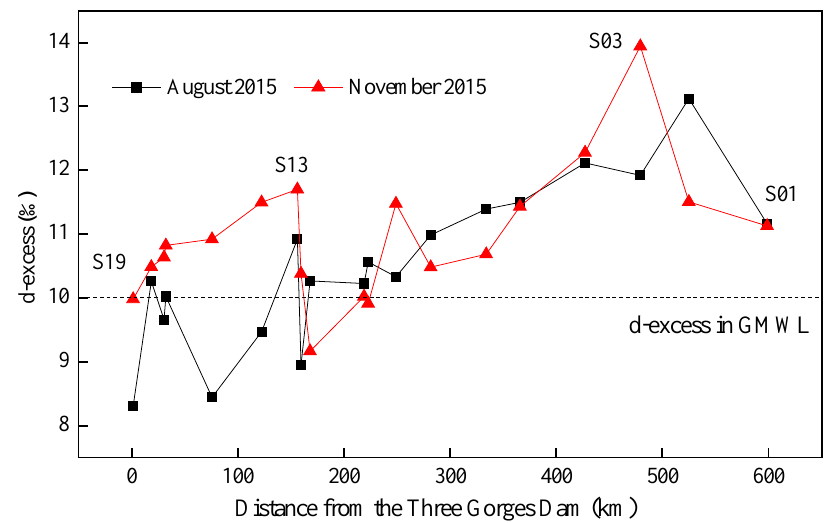
Figure 5. The fluctuations of d-excess in the TGR mainstream water during the dry and wet seasons. GMWL: Global Meteoric Water Line [18].